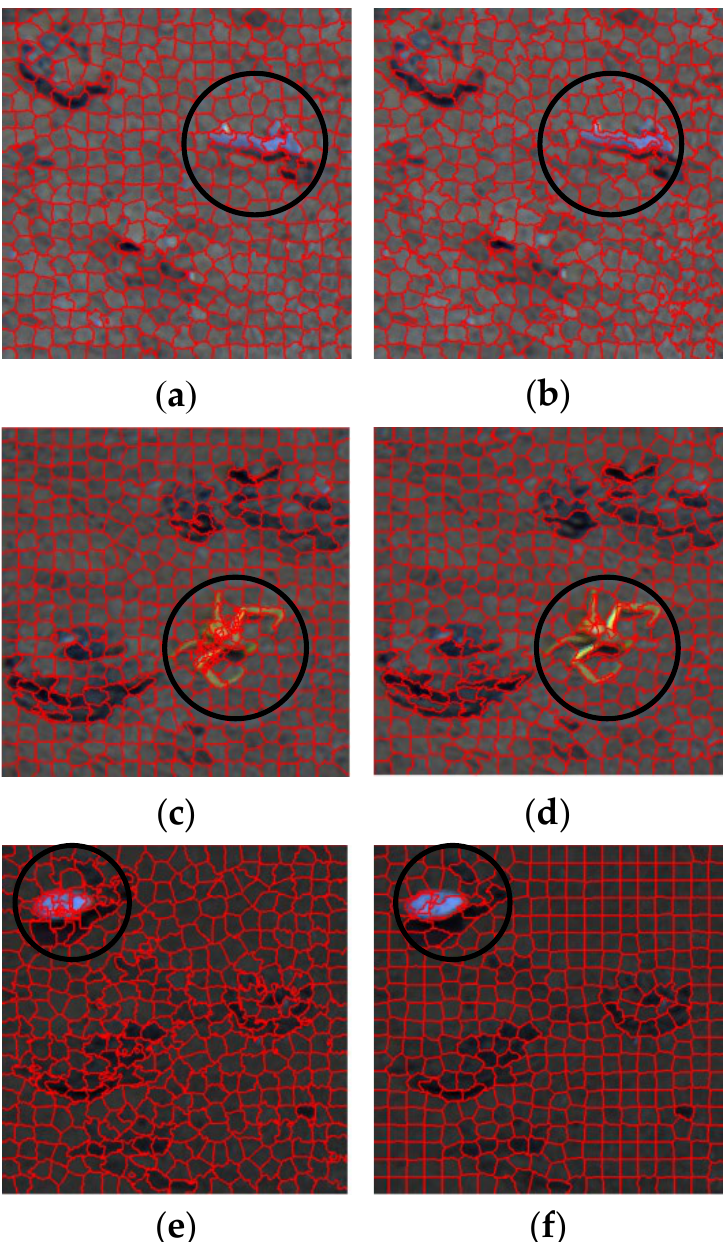
Figure 4. Partial segmentation diagram. ( a ) the No.7 dataset (Ours) ( b ) the No.7 dataset (MSLIC) ( c ) the No.4 dataset (Ours) ( d ) the No.4 dataset (MSLIC) ( e ) the No.10 dataset (Ours) ( f ) the No.10 dataset (MSLIC).